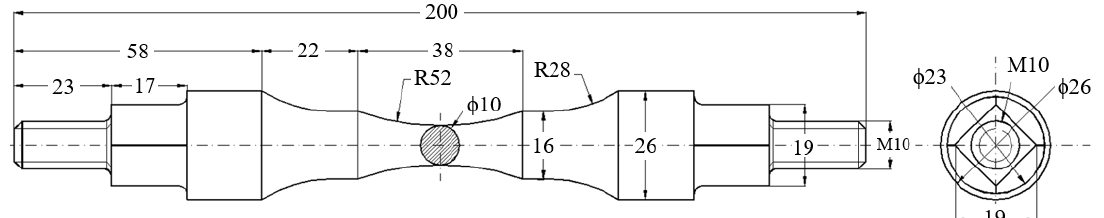
Figure 3. Geometric configuration and dimensions of the specimen.